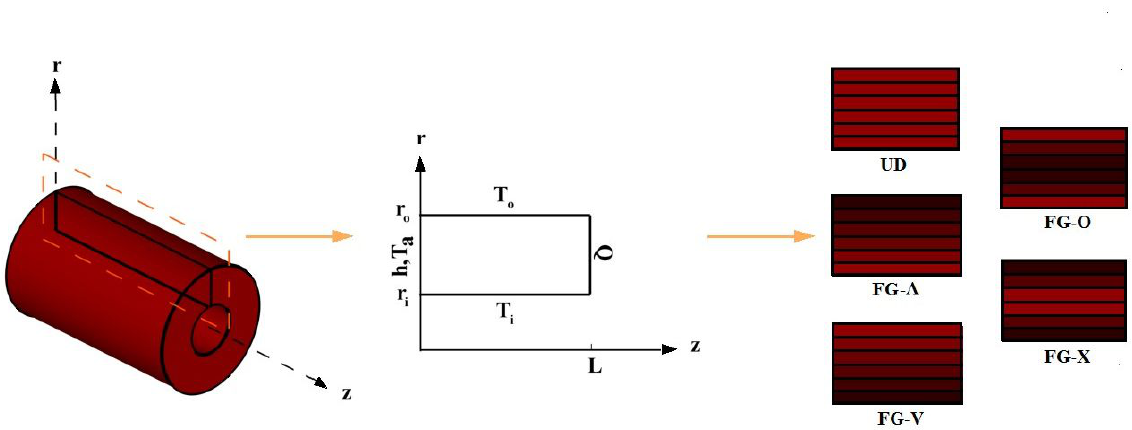
Figure 1: Axisymmetric nanocomposite cylinders with UD and FG distribution patterns of nanofillers subjected to various thermal boundary